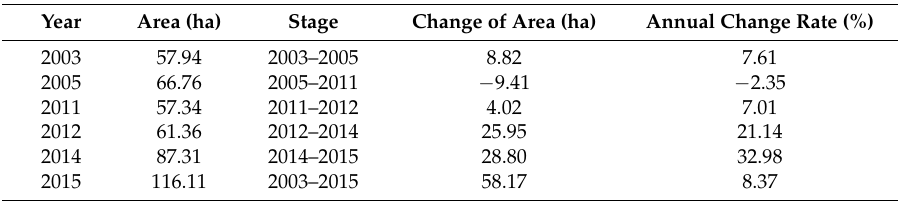
Table 3. Area of S. alterniflora from 2003-2015 and its changes during different stages Year Area (ha) Stage Change of Area (ha) Annual Change Rate (%)